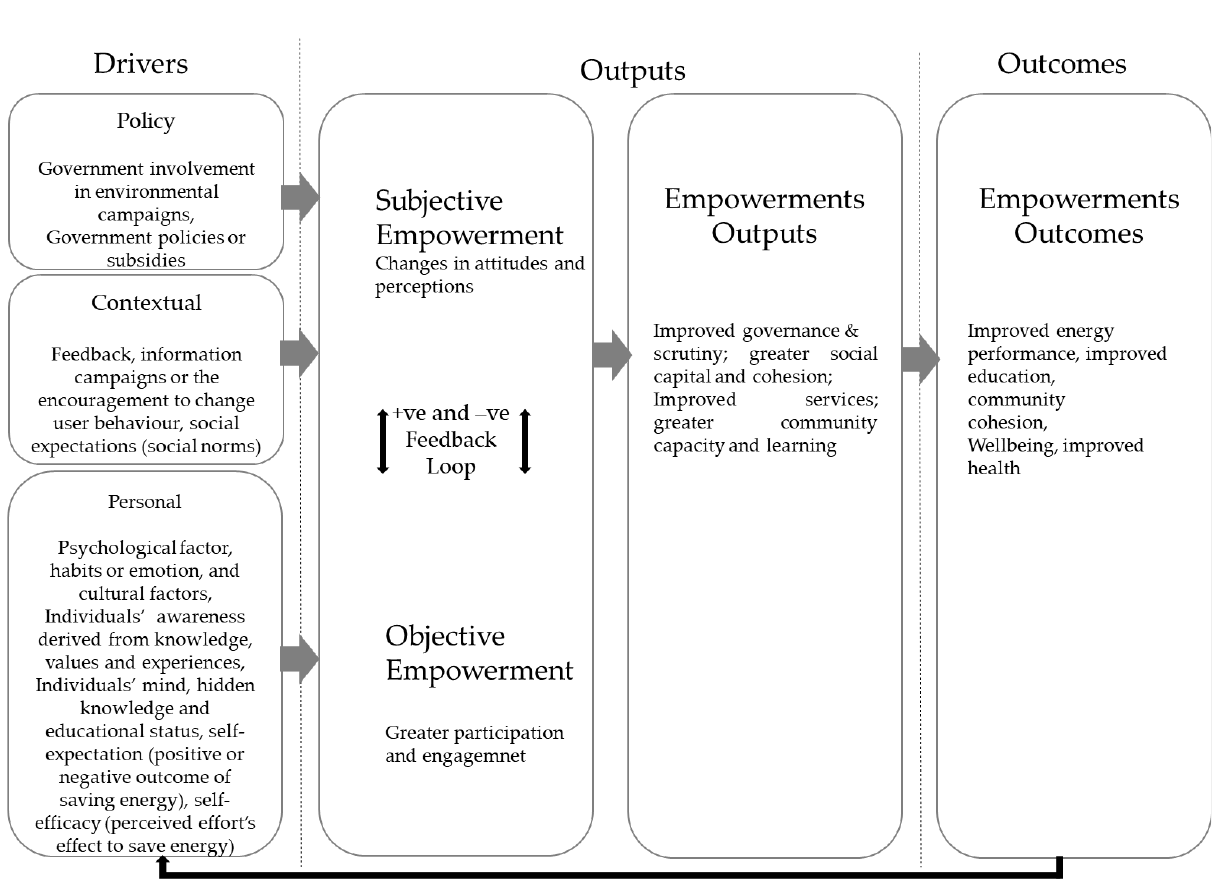
Figure 6. The framework of changing behaviours and increasing people’s participation in EER projects [133, 160].